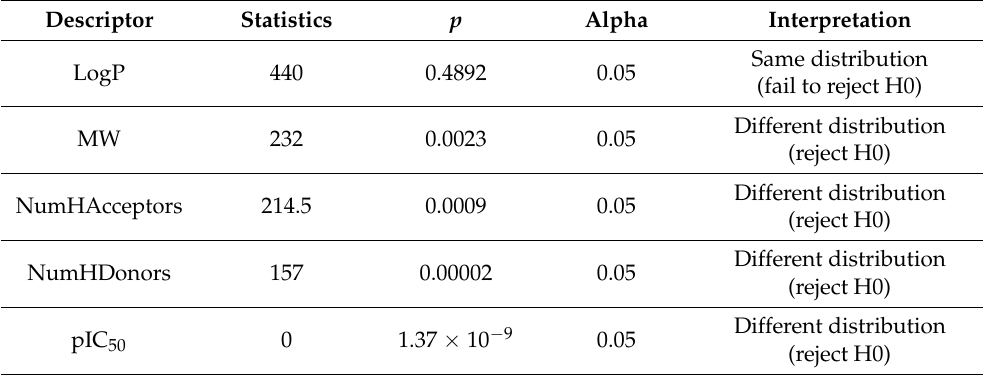
Table 1. Mann–Whitney U test